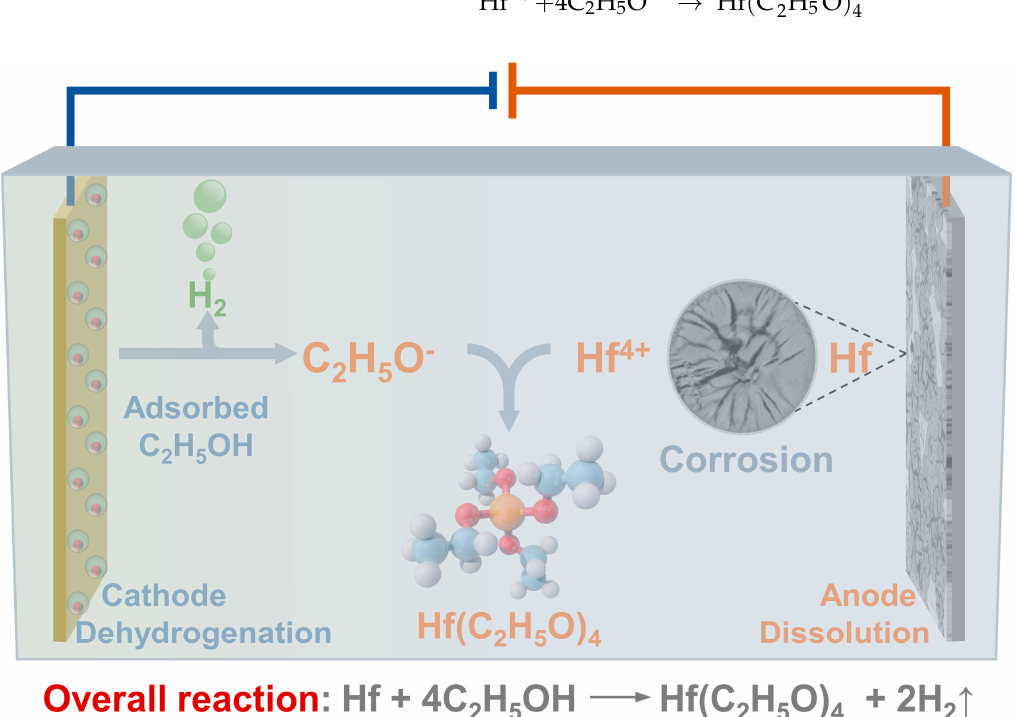
Figure 1. Theoretical mechanism of Hf(OR) 4 electro-synthesis process based on anodic